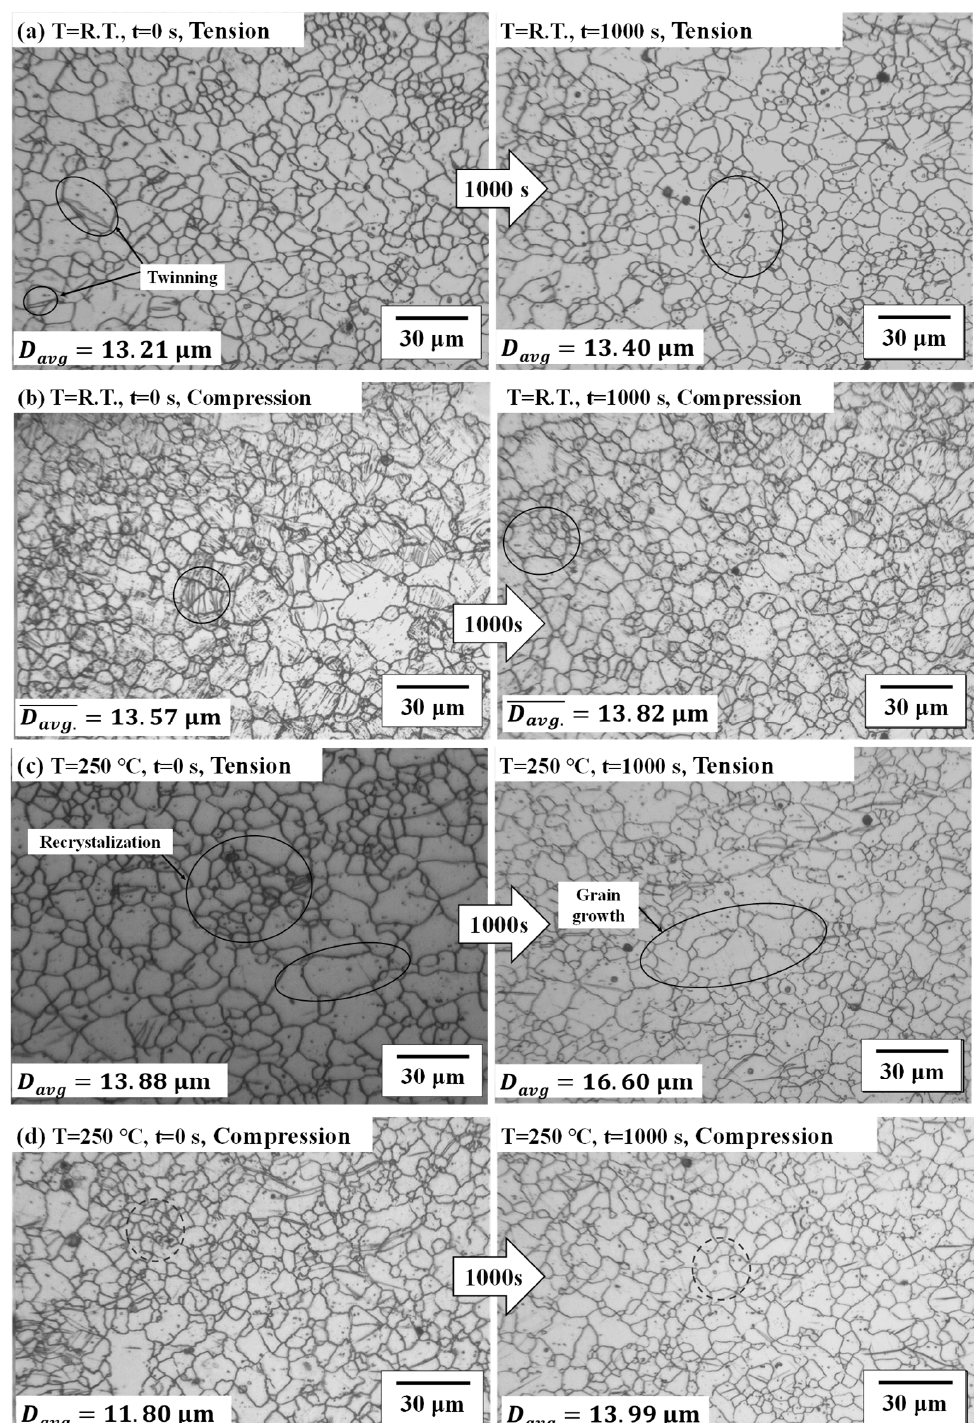
Figure 22. The microstructure of AZ31B after V-bending process according to material holding time ( a ) on the outer side (tensile deformation) at 1000 s and 20 °C, ( b ) on the inner side (compressive deformation) at 1000 s and 20 °C, ( c ) on the outer side at 1000 s and 250 °C, and ( d ) on the inner side (compressive deformation) at 1000 s and 250 °C.